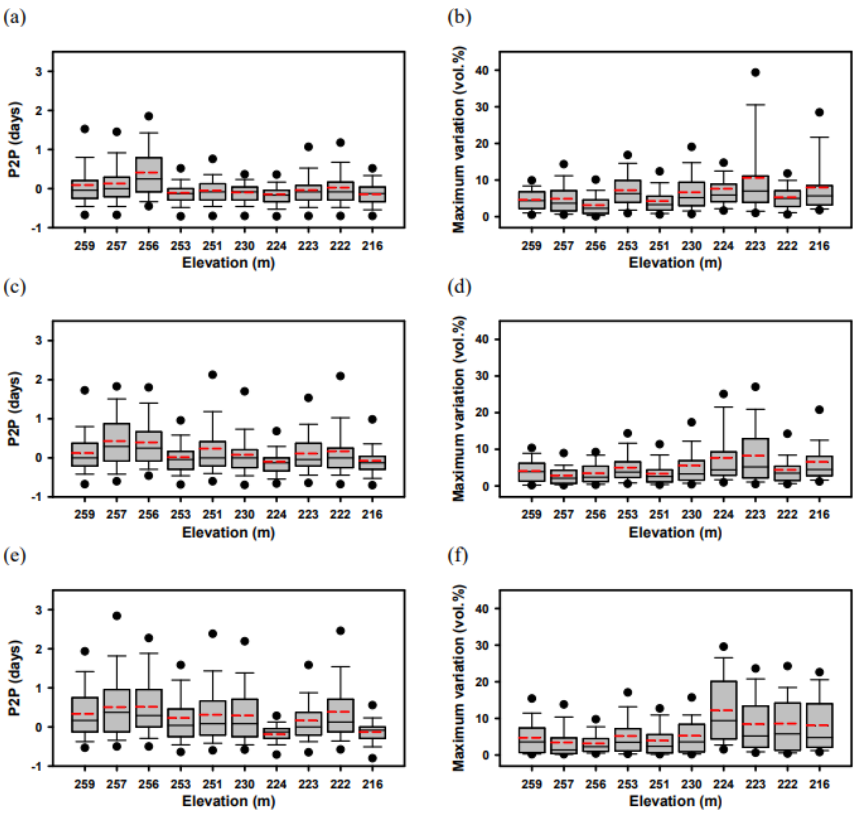
Figure 2. Box plots illustrating soil moisture responses of P2P and maximum variation at 10cm depth (a, b) , at 30cm depth (c, d) , and at 60cm depth (e, f) , respectively. Elevations on the x axis are between 260 and 215m in order of UP1–UP4–UP2–UP5–UP3–DO1–DO2– DO3–DO4–DO5, shown in Fig.